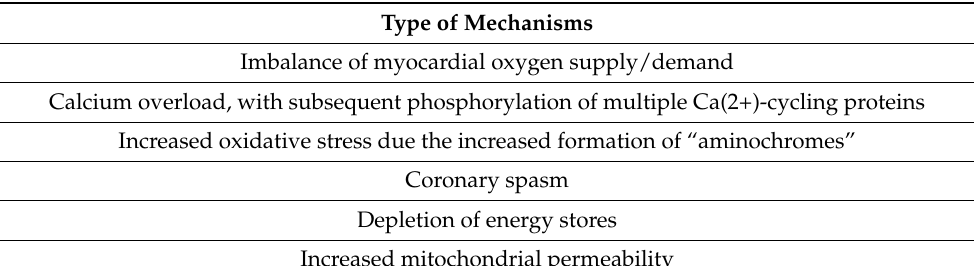
Table 1. Proposed mechanisms of catecholamine